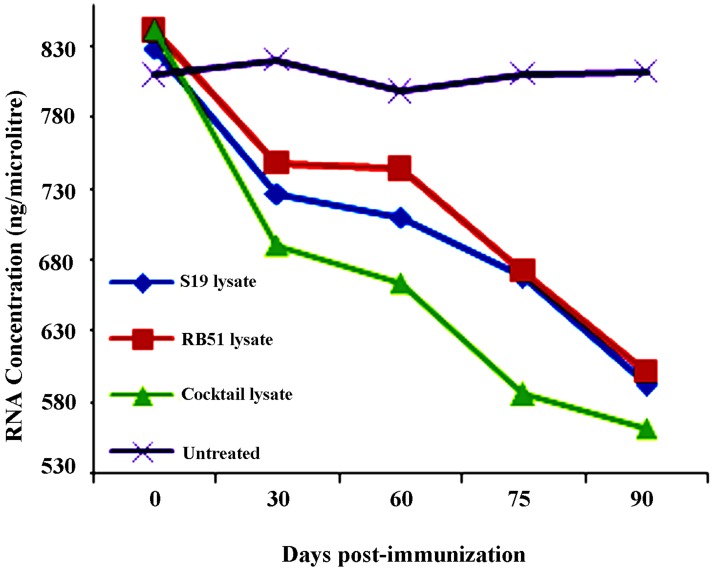
Levels of RNA in plasma of lysate treated or untreated cattle.